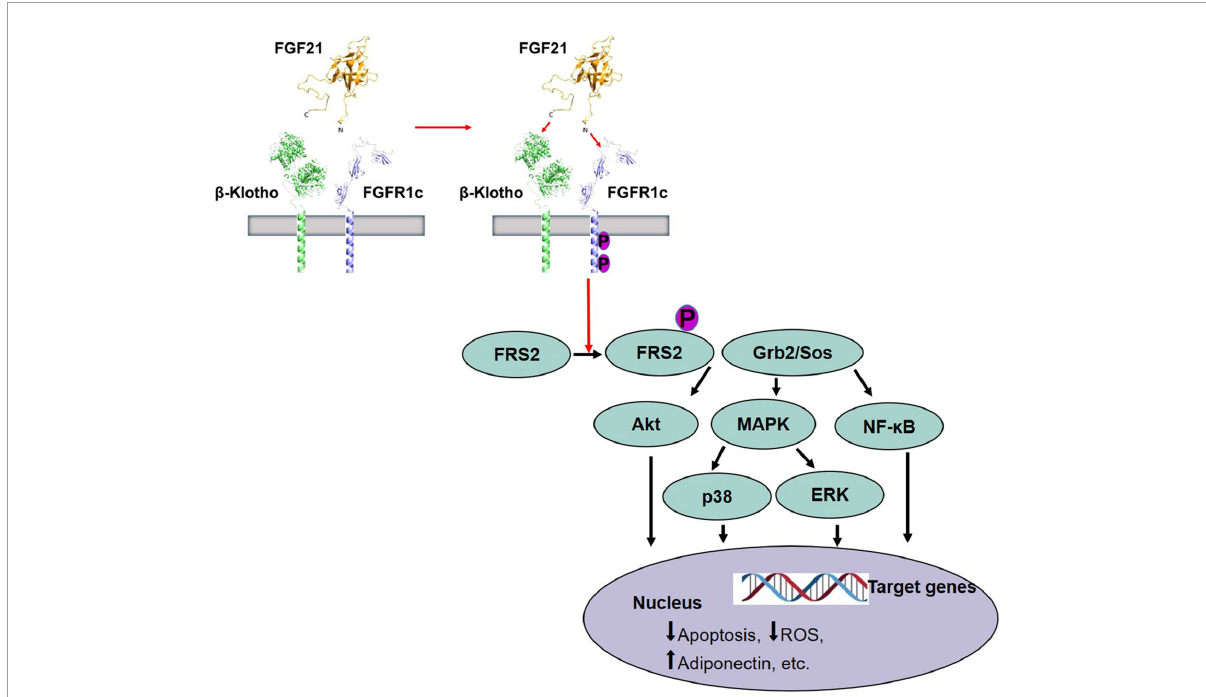
FIGURE1 Activation of FGFR1c by FGF21 and signaling pathway (42). FGF21 receptor consists of FGFR1c and co-receptor β -Klotho that are constitutively associated with the plasma membrane. The C-terminus of FGF21 interacts with β -Klotho, and β -Klotho is necessary for FGF21 to perform the function. Then, the N-terminus of FGF21 binds to FGFR to form a stable FGF21/ β -Klotho/FGFR complex and leads to autophosphorylation of FGFR1, and phosphorylation of FRS2, which then forms a complex with Grb2/Sos to activate downstream molecular signals, such as Akt pathway, MAPK/p38 pathway, MAPK/ERK pathway, and NF- κ B pathway, causing the change of target genes in the nucleus. FGF21, fibroblast growth factor 21; FGFR, FGF receptor; Akt, protein kinase B; MAPK, mitogen-activated protein kinase; ERK, extracellular signal-regulated kinase after FGF